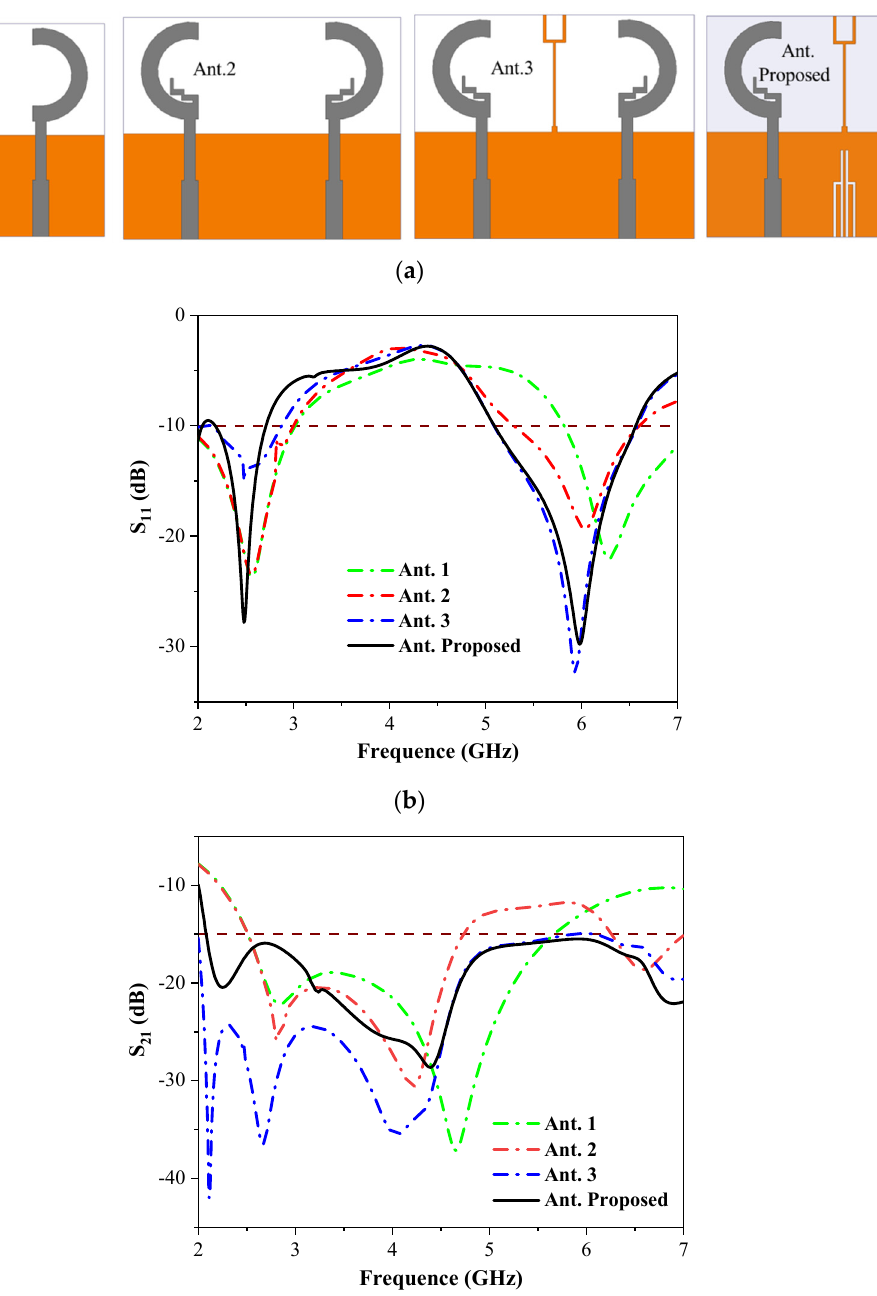
Figure 2. Evolution of the proposed antenna. ( a ) Structure of antenna 1, 2 and 3 and proposed; ( b ) simulated S 11 ; ( c ) simulated S 21 .